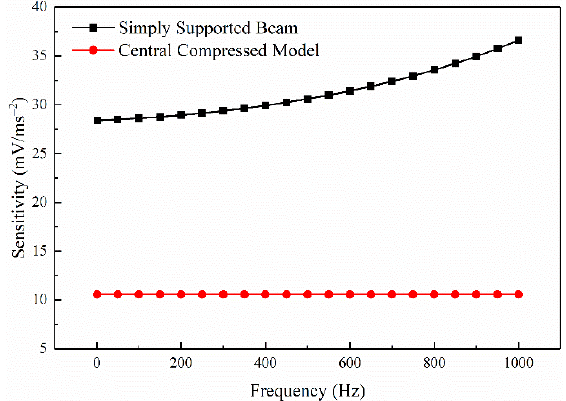
Figure 8. ( a ) The schematic of the central compressed model; ( b ) The central compressed model.